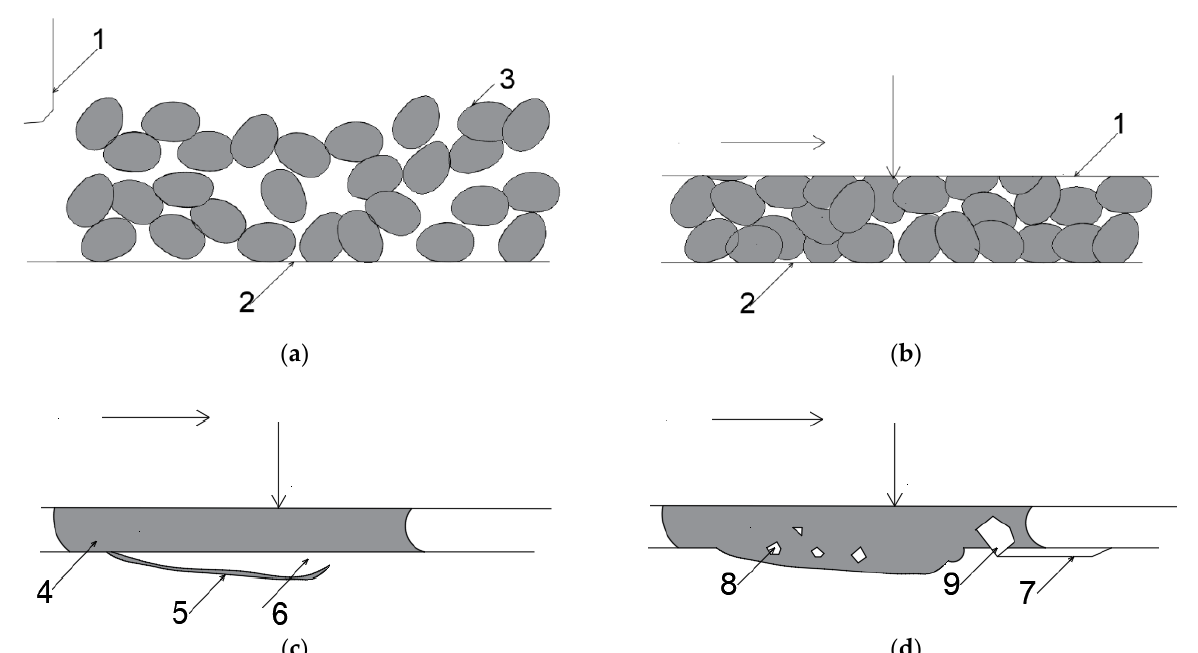
Figure 17. Wear model of the real system with the presence of coal grains: scraper sliding on the metal sheet surface, ( a )—Stage I (initial state), ( b )—Stage II (crushing and initial consolidation of coal grains under the load and the scraper advance), ( c )—Stage III (complete crushing, final consolidation of the surface layer and fatigue chipping), ( d )—Stage IV (crushing of chipping debris and surface cutting by the wear debris); symbols: 1—scraper, 2 –metal sheet, 3—coal grains, 4—consolidated coal layer, 5—coal wedge, 6—flat fatigue fracture, 7—micro-cut, 8—crushed debris particles located in the coal layer, 9—incompletely crushed debris particle.